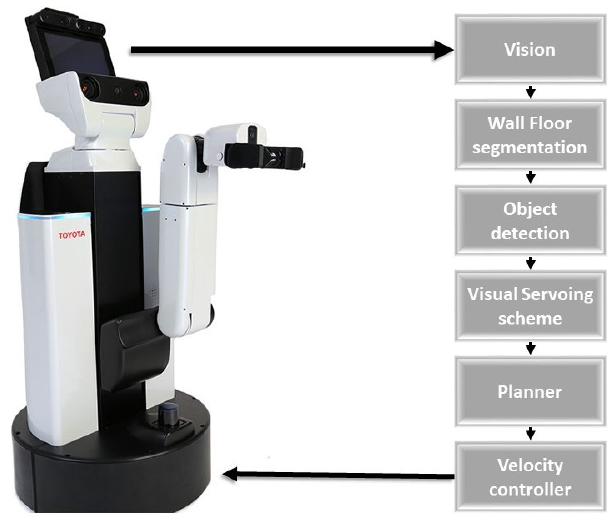
Figure 1. Overview of the Proposed Scheme.